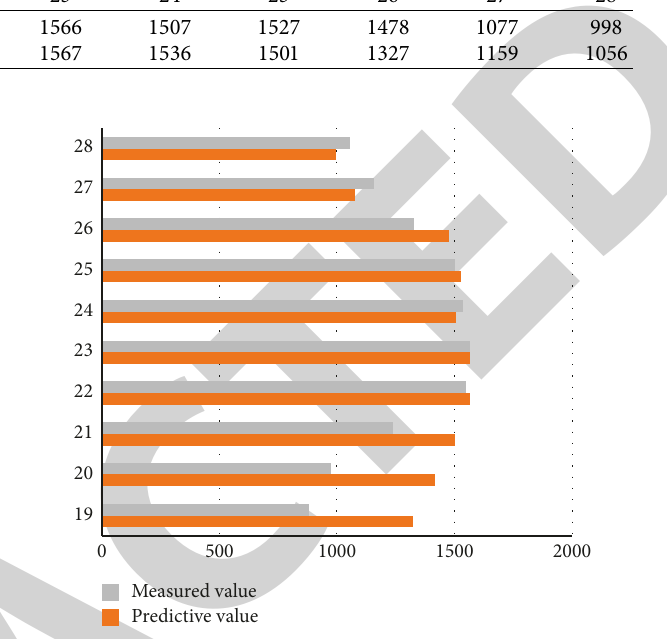
Figure 4: Contrast curve between predicted and measured